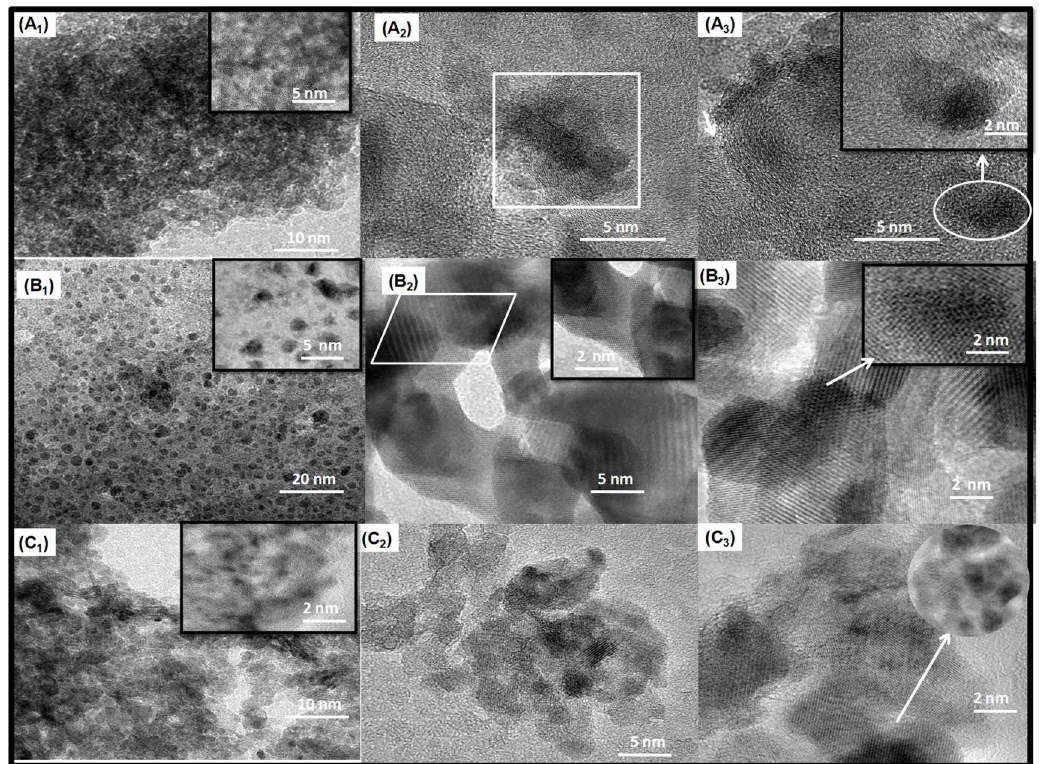
Figure 6. TEM images of the supported samples: ( A ) NiCo/LA, ( B ) NiCo/MA and ( C ) NiCo/ZA samples. Insets illustrate parts of the figure at higher magnifications.